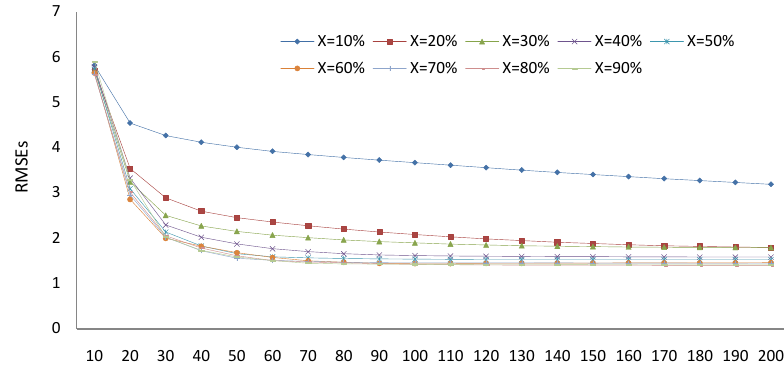
Figure 3. Empirical studies on convergence speed.